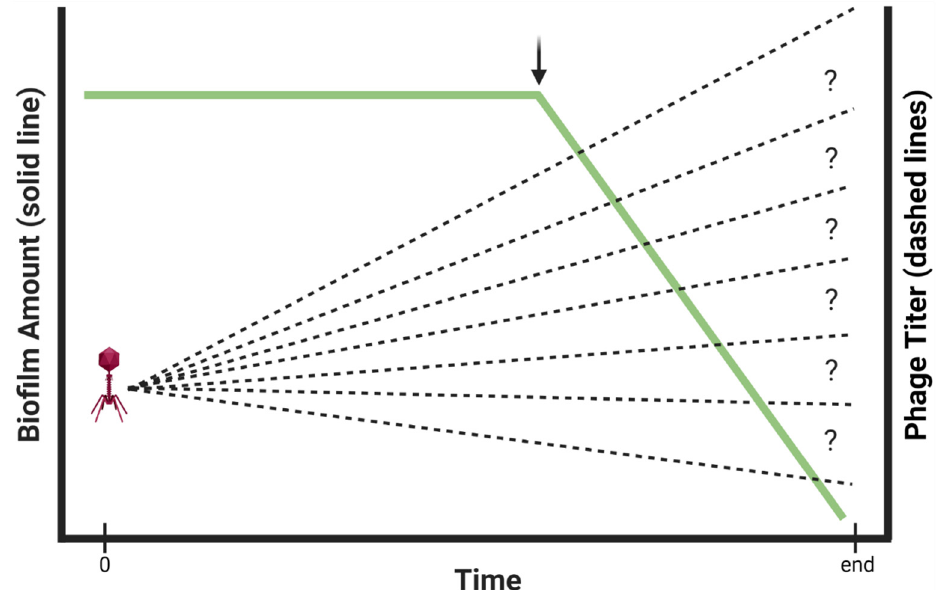
Figure 3. What phage titer ultimately is required to clear biofilms? Solid line: biofilm presence. Dashed lines: phage titer and increase due to in situ phage propagation, as starting with an MOI of somewhat less than 1. Scales for y axes to the left and to the right are not necessarily equivalent. Illustrated is the idea that there is little possibility of understanding phage-bacterial population dynamics without quantifying phage titers over time in combination with at what point in time biofilm amounts start to be reduced (arrow). Toward increasing clarity, depiction of synchronous phage replication, e.g., as seen in Figure 1 of [80], is intentionally not provided in the figure. Created with